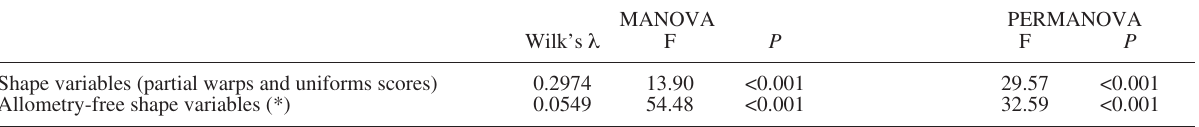
Table 2. – Statistical analyses to test for shape differences between sampling locations.